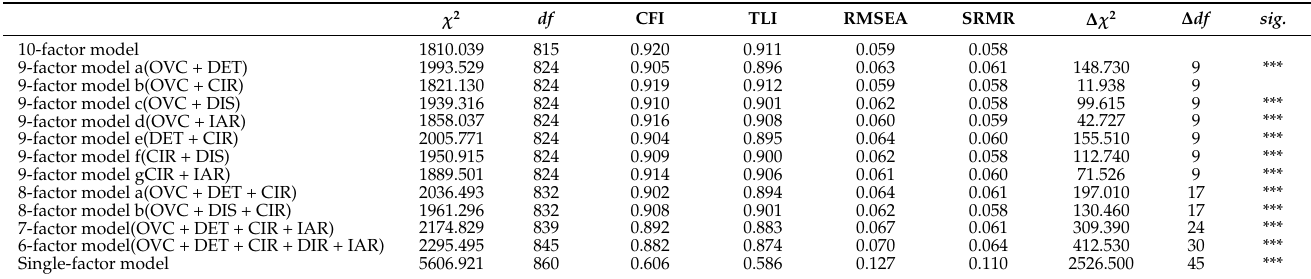
Table 5. Fit Indices of the Multi-level Confirmatory Factor Analysis Models in Sample 2.